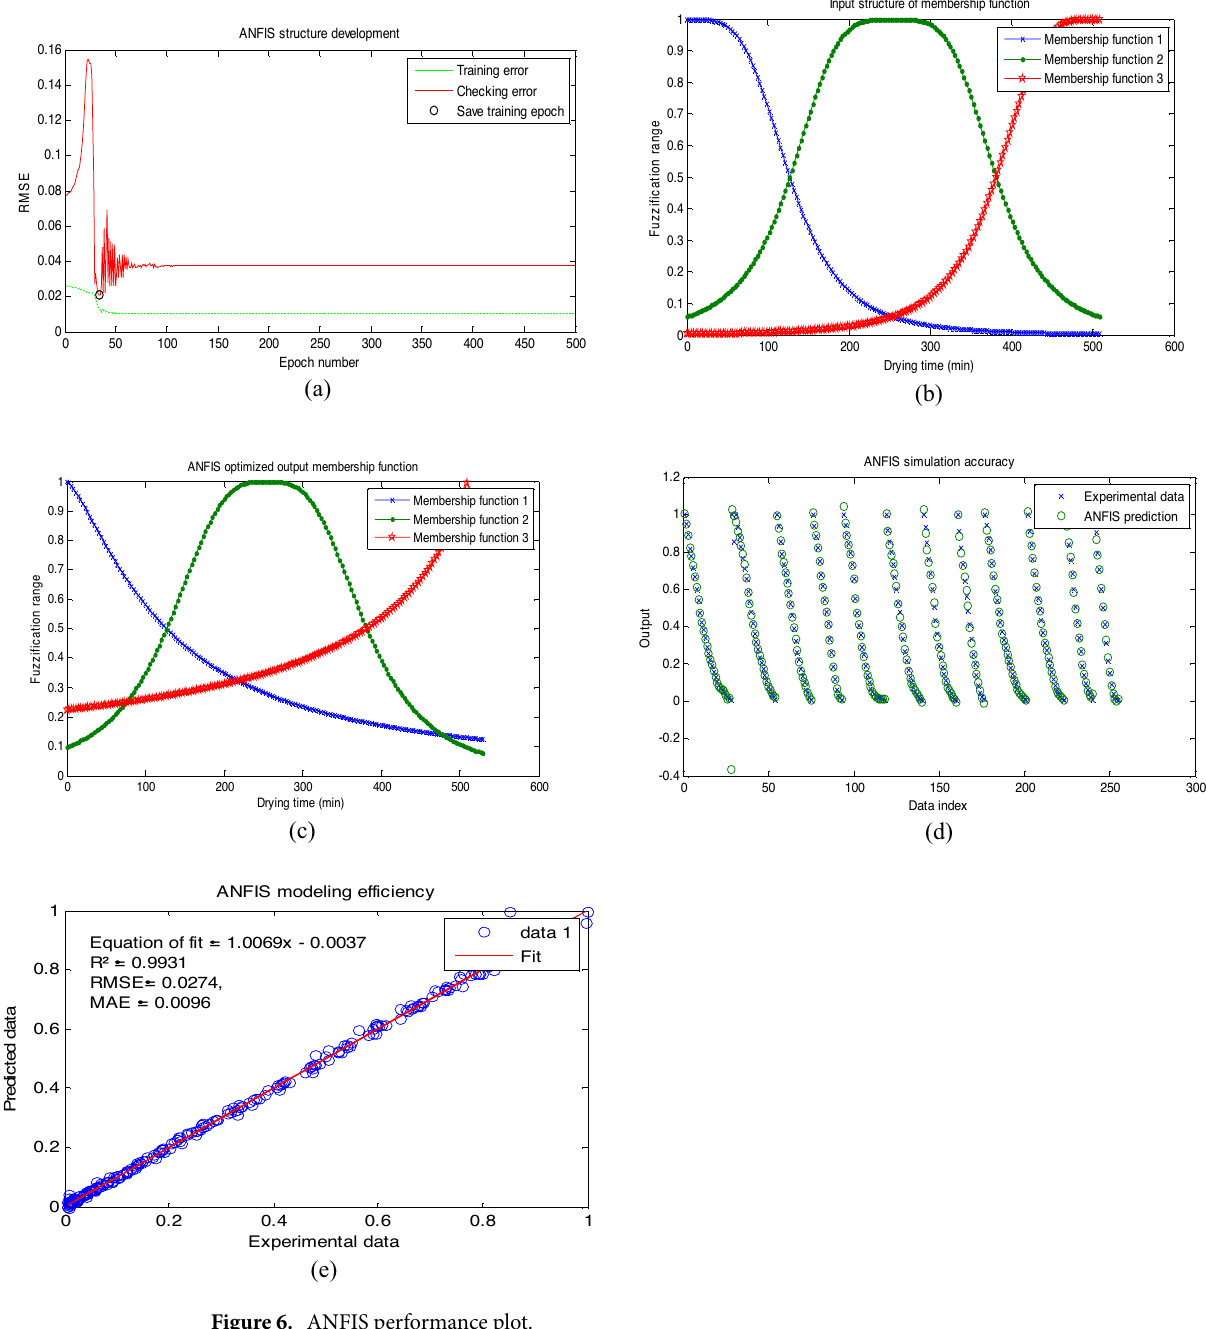
Figure 6. ANFIS performance